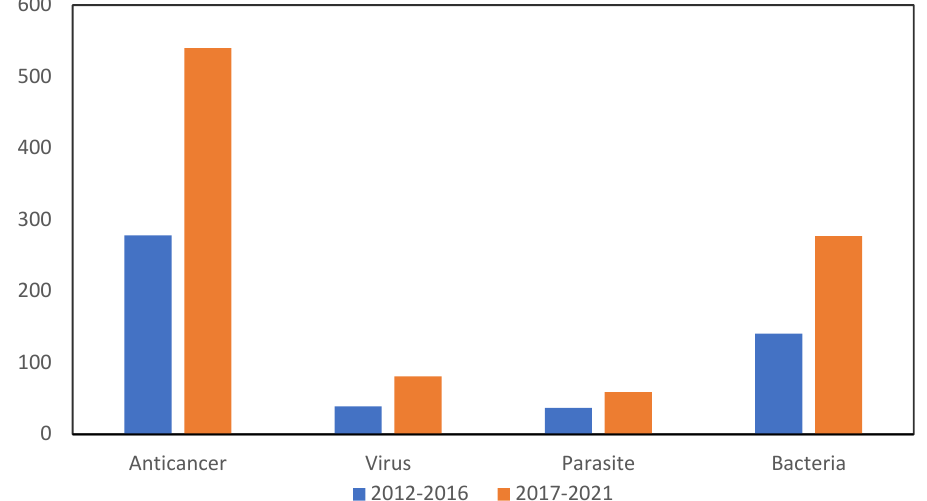
Figure 2. Number of articles indexed to Web of Science where gold compounds are investigated for biological activity against cancer, parasitosis and viruses in last decade (2012 – 2021).